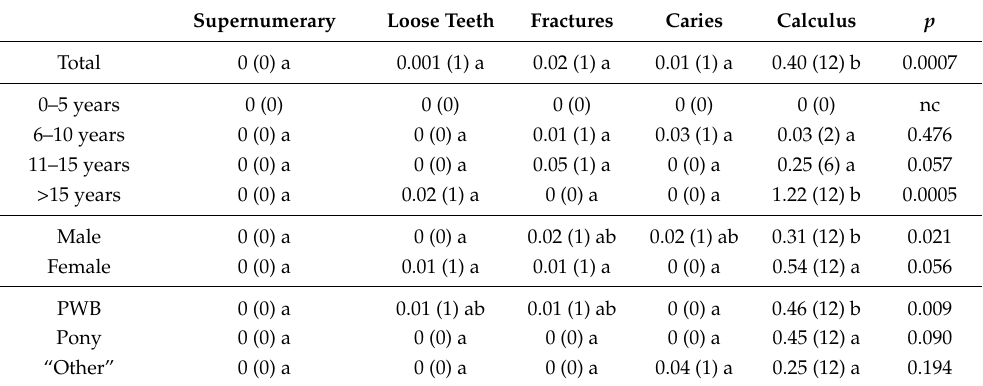
Table 6. The frequency distribution of dental diseases of incisor teeth in the total 7912 examined teeth of 206 horses.